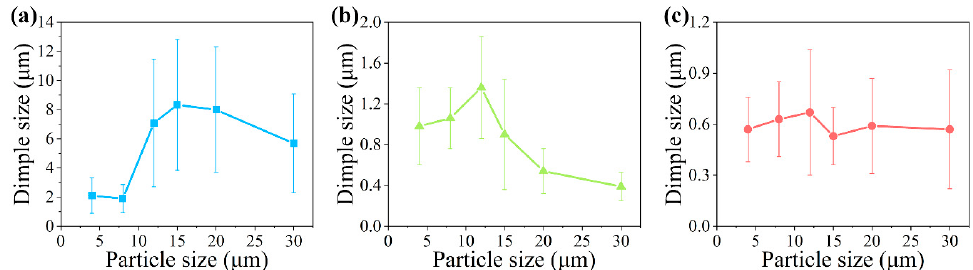
Figure 5. Average dimple sizes on the fracture surfaces of the composites with ( a ) matrix L, ( b ) matrix M, and ( c ) matrix H. The error bars show the variation range in the dimple size in one composite.